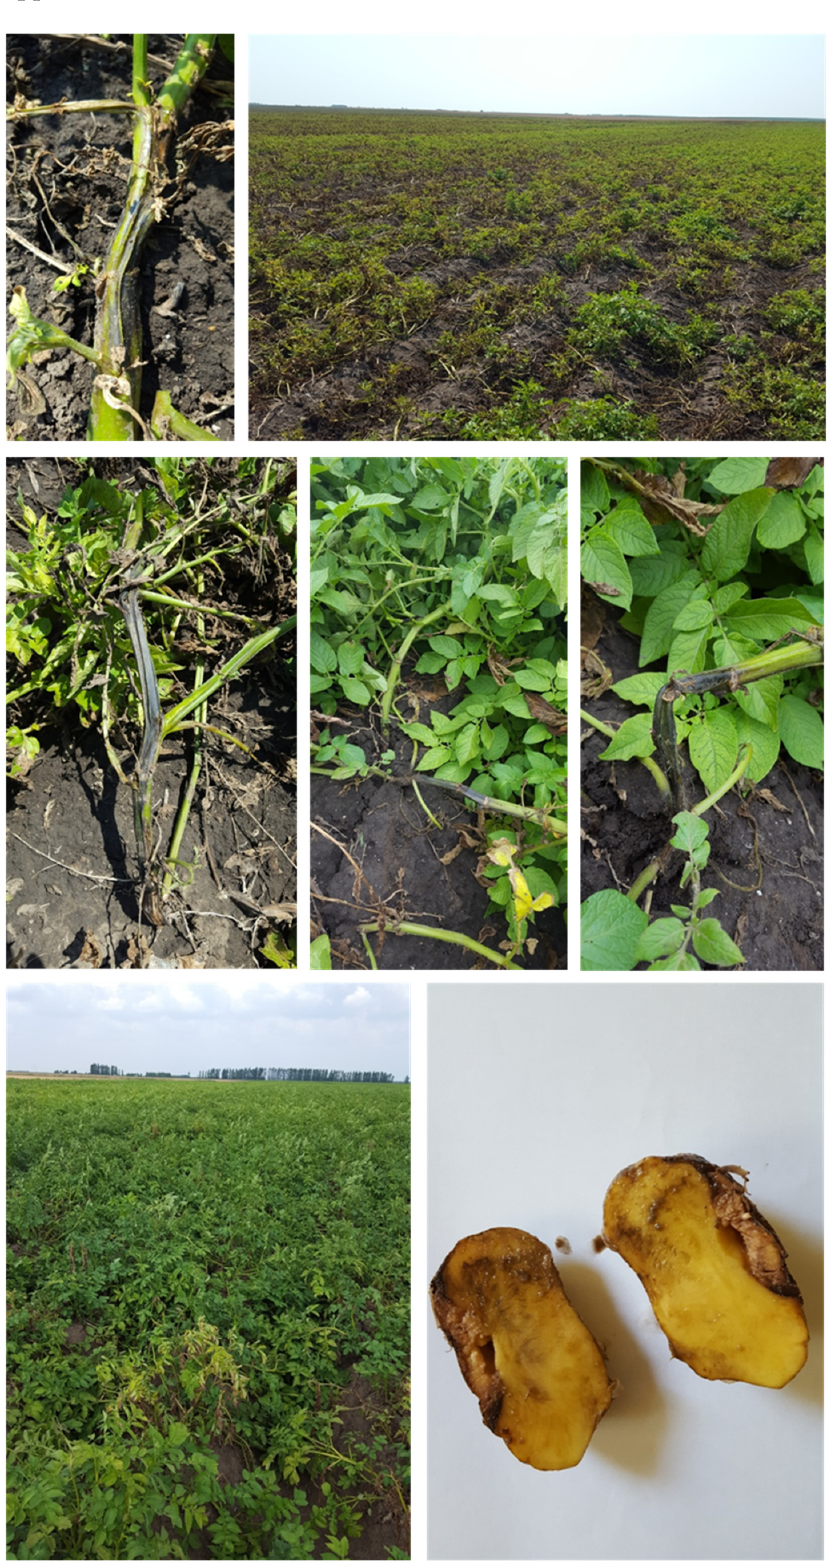
Figure A1. Potato blackleg, aerial stem rot, wilt, chlorosis and tuber soft rot symptoms detected in potato growing fields in the Province of Vojvodina during 2018–2020.